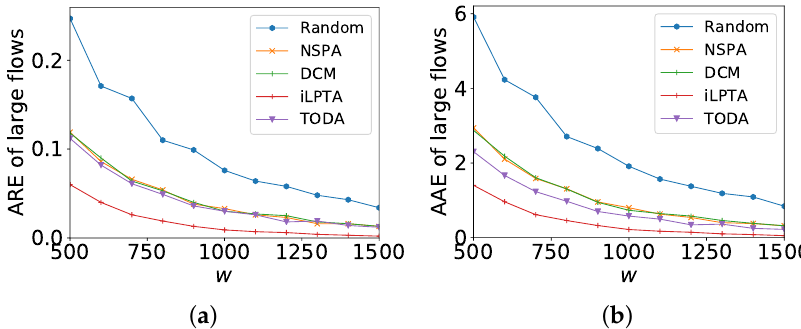
Figure 6. Measurement accuracies of large flows with different w . ( a ) ARE; ( b ) AAE.